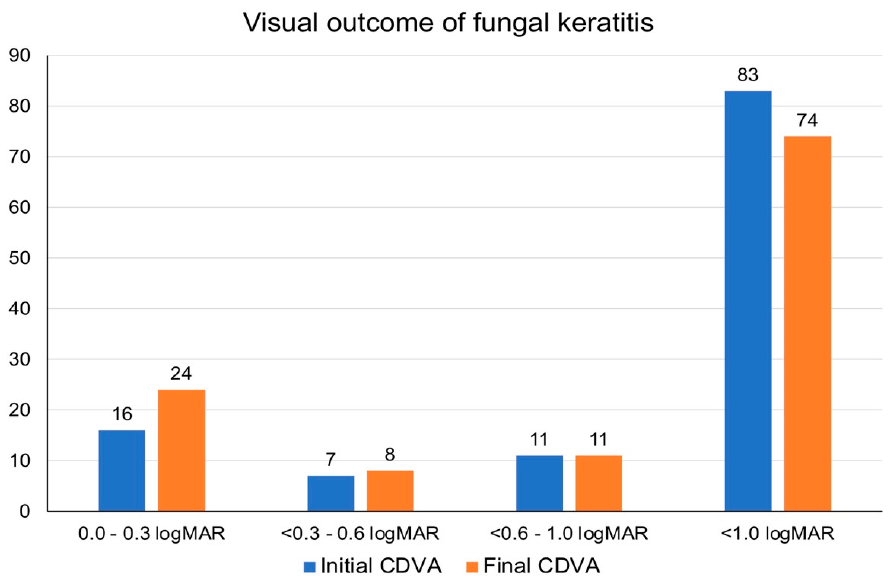
Table 5. Prognostic factors for poor visual outcome [defined as corrected-distance-visual-acuity (CDVA) of <1.0 logMAR]. and poor corneal healing (defined as >60 days to achieve complete healing or required tectonic/therapeutic keratoplasty, evisceration or enucleation) in fungal keratitis in the UK.